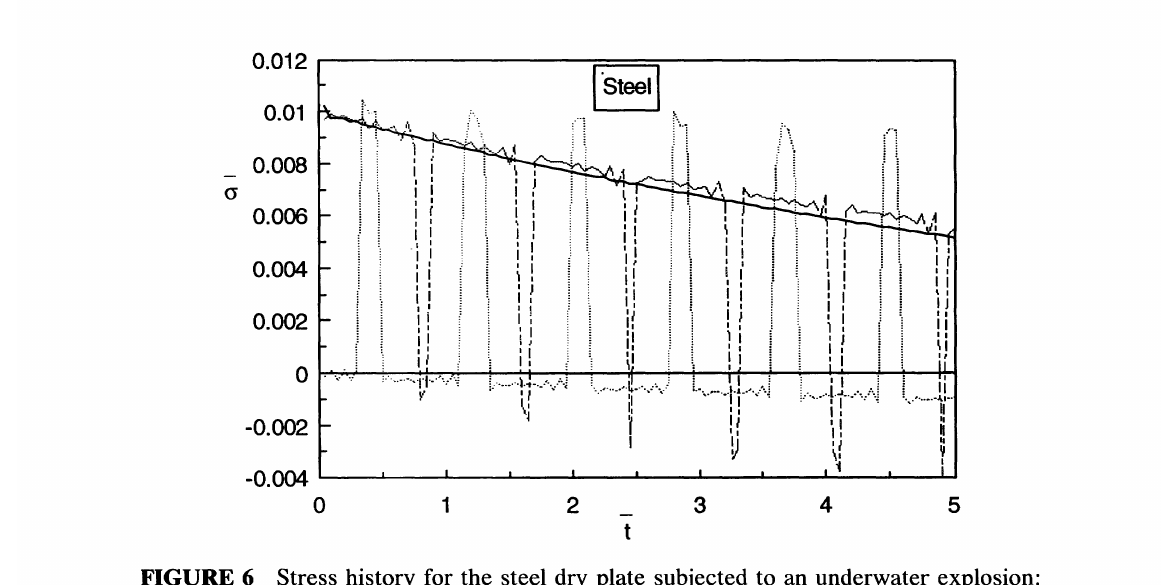
FIGURE 6 Stress history for the steel dry plate subjected to an underwater explosion: (-) x = H, ( ... ) x = 0.2H, (---) x = 0.9H; TNT, 20 kg, D = 10